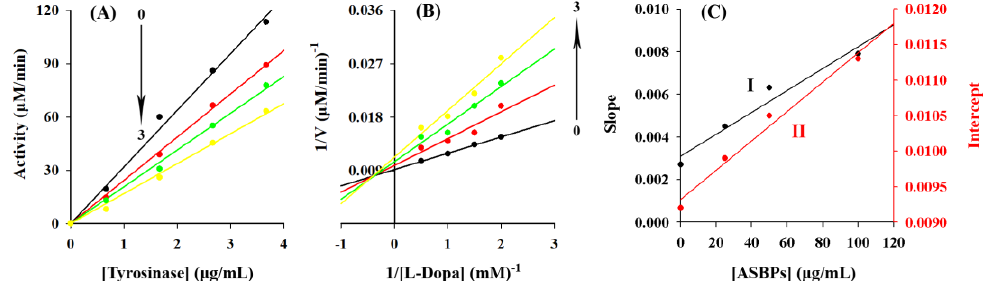
Figure 5. ( A ) Determination of the inhibitory mechanism of ASBPs on diphenolase in tyrosinase; ( B ) Lineweaver-Burk plots for inhibition of ASBPs on tyrosinase for the catalysis of L-DOPA; ( C ) Sec- ondary plots of slope and intercept versus the concentration of ASBPs. Curves 0 – 3 represent ASBPs concentrations of 0, 25, 50 and 100 µg/mL, respectively.